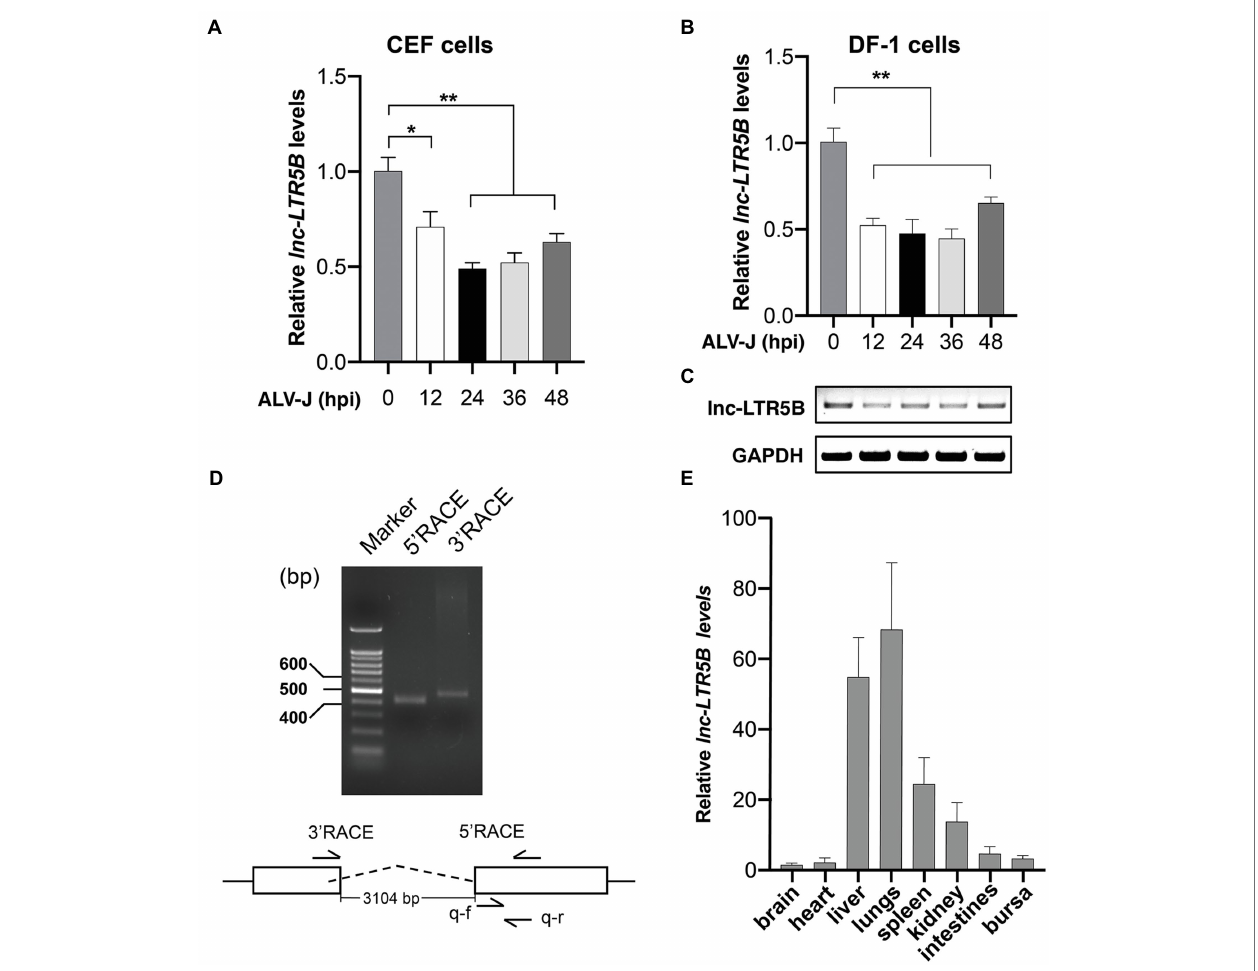
FIGURE 1 | ALV-J infection downregulates lnc-LTR5B expression. (A,B) CEF cells (A) and DF-1 (B) cells were infected with ALV-J (Multiplicity of infection, MOI = 0.5) for the indicated time intervals. The relative levels of lnc-LTR5B were measured by qRT-PCR. (C) RT-PCR analysis of the expression of lnc-LTR5B in DF-1 cells treated as described in (B) . (D) Agarose gel analysis of 5 ' and 3 ' RACE PCR products for lnc-LTR5B. DNA ladders (400 bp, 500 bp, and 600 bp) are shown (left lane). (E) qRT-PCR analysis of the expression of lnc-LTR5B in multiple tissues in chicken. GAPDH mRNA served as an internal control to normalize the level of lnc- LTR5B. Data are presented as the mean ± SD, n = 3; * p < 0.05, ** p < 0.01 (one-way